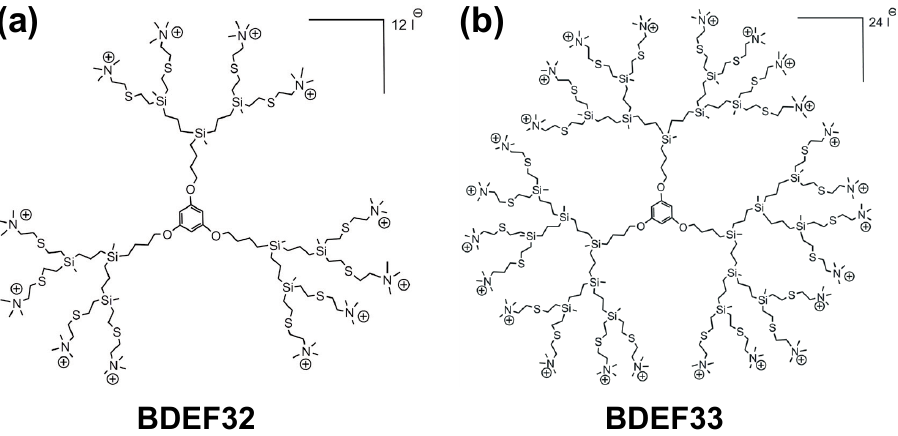
Figure 1. Molecular structures of the cationic carbosilane dendrimers of the ( a ) second (BDEF32) and ( b ) third (BDEF33) generation used in the study.